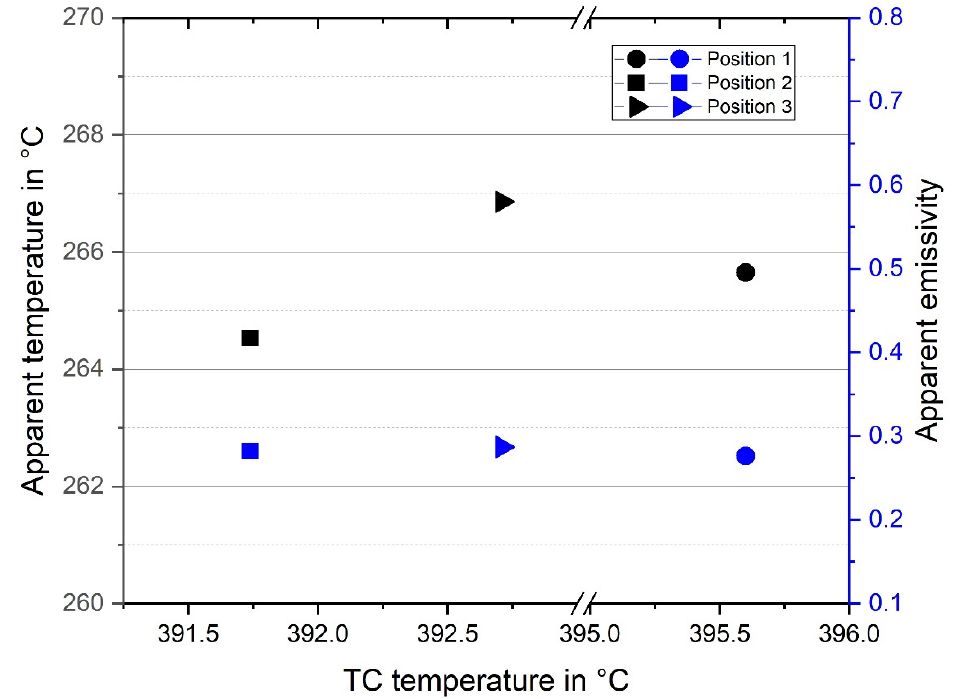
Figure 16. Apparent temperature and apparent emissivity of a 316L L-PBF bulk surface at three different positions within the build chamber according to the positions shown in Figure 7.